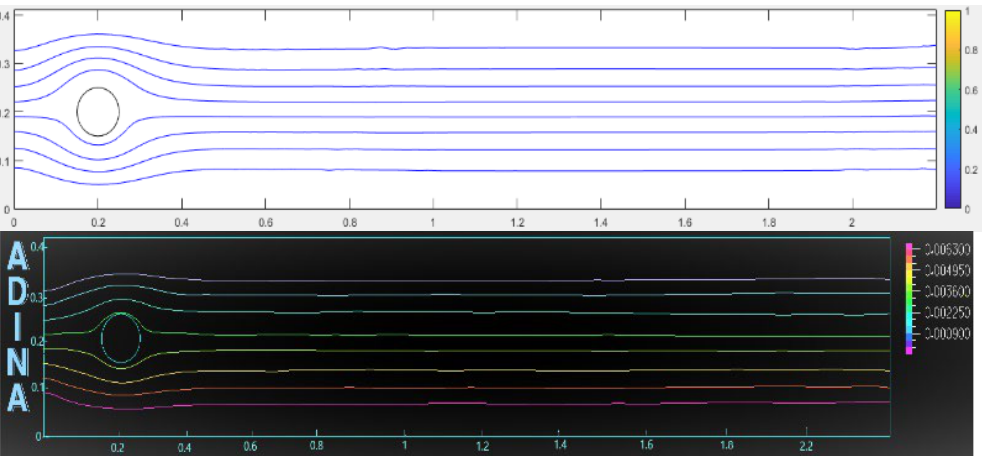
Figure 7. Solution computed with MATLAB (above) and with the ADINA system (below). The plots show the streamlines associated with a α 1 = α 2 = 10 − 6 .